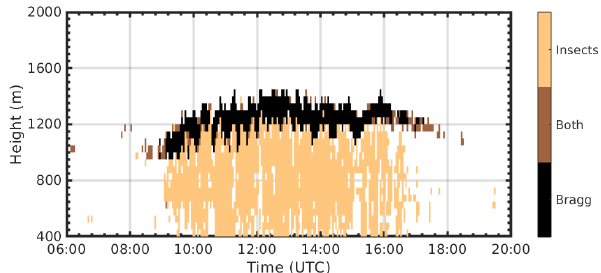
Figure 4. The Bragg–insect classification mask for 9 May 2018. Bragg scatter is shown with a continuous black line in the upper part of the CBL, and insects (in yellow) occupy most of the CBL. Measurements that remain unclassified are coloured in